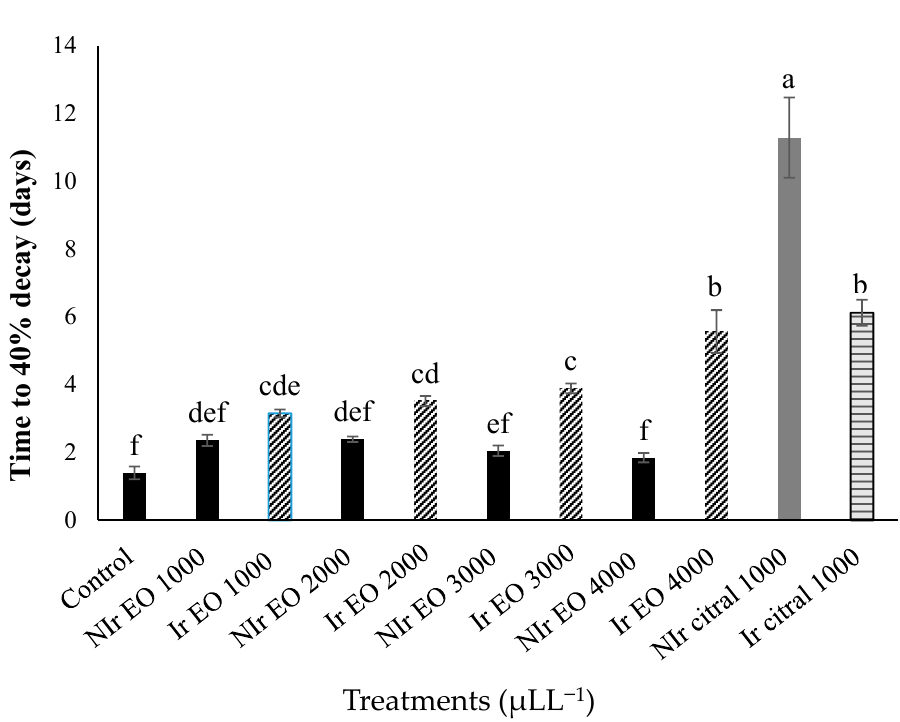
Figure 1. Time to reach 40% decay of oranges inoculated with P. digitatum and dipped with irradiated (Ir) and non-irradiated (NIr) orange EO and citral. The value for each treatment is the mean of nine treatment units (three replicates x three batches of fruit). The bars on each treatment are the mean standard errors. Different letters indicate a significant difference between treatments at p = 0.05.